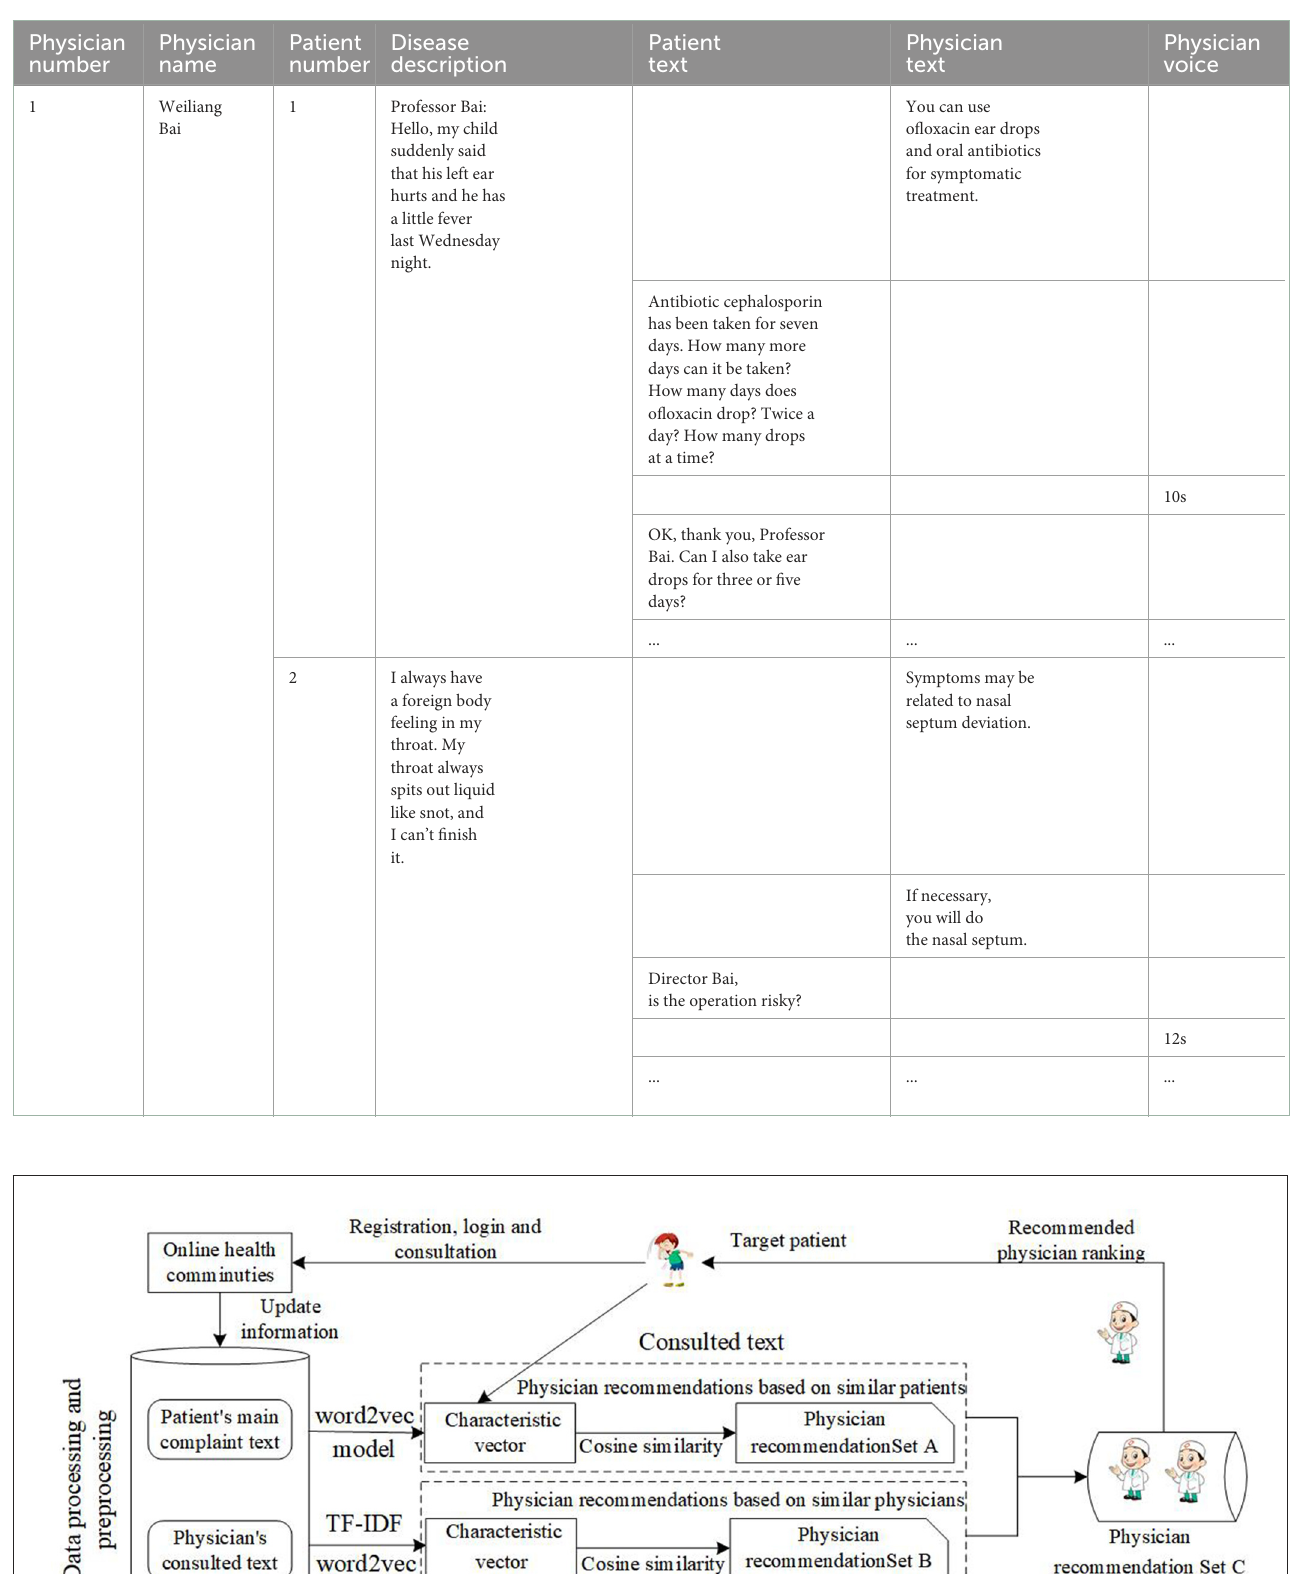
TABLE 5 Patient-physician communication text.